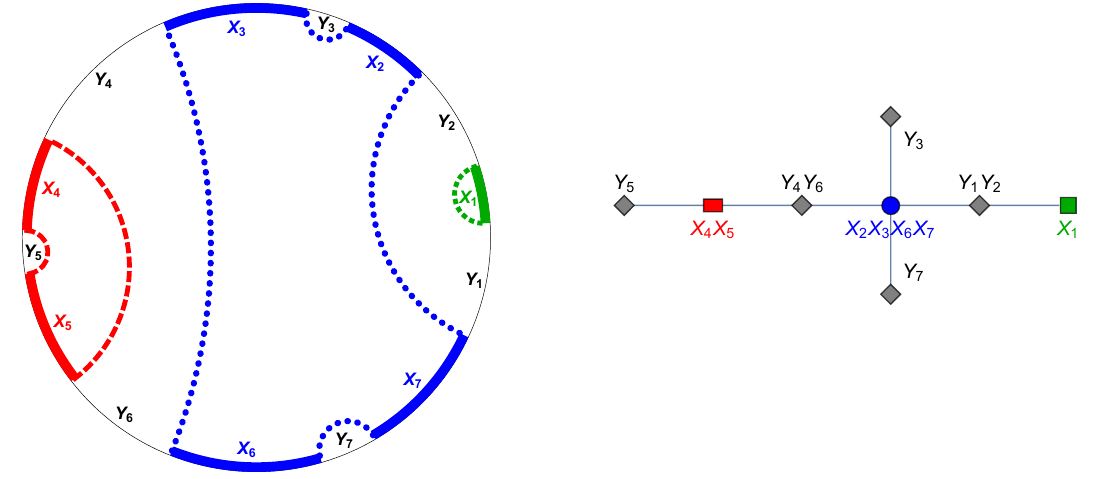
Figure 2 . The phase ( X 4 X 5 )( X 2 X 3 X 6 X 7 )( X 1 ) of a seven-interval region on a circle and its coloring tree (see